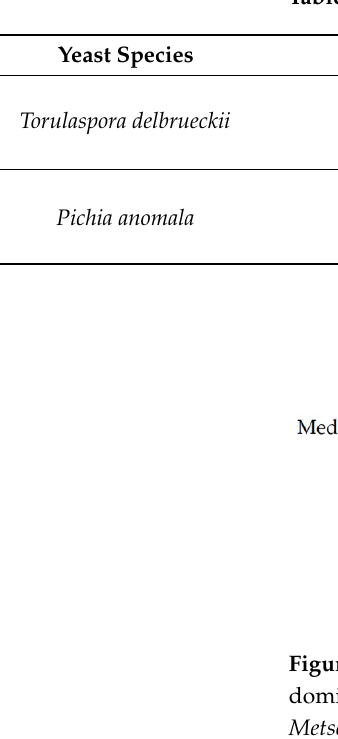
community than grape variety and maturation state.